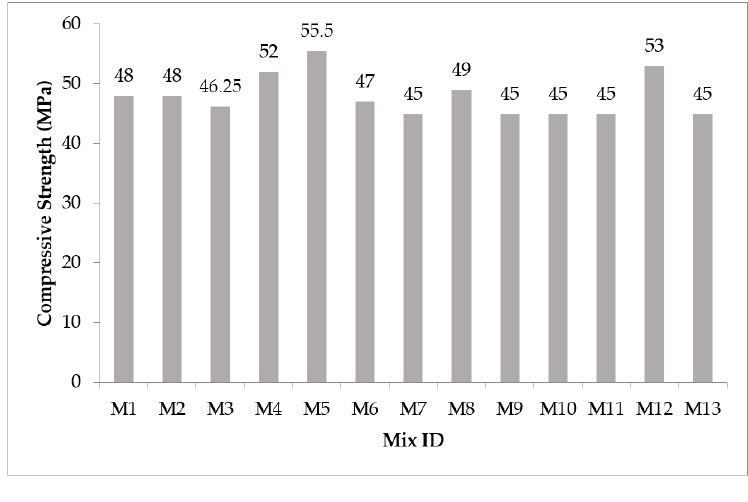
Figure 2. CS at 28 days.